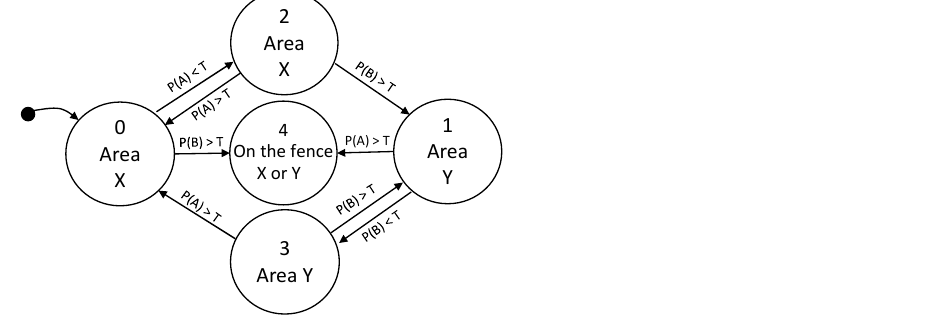
Figure 7. Finite state machine that estimates the location of a receiver relative to the virtual fence of Figure 6. Transitions are based on the proximity function to beacons A and B [38].